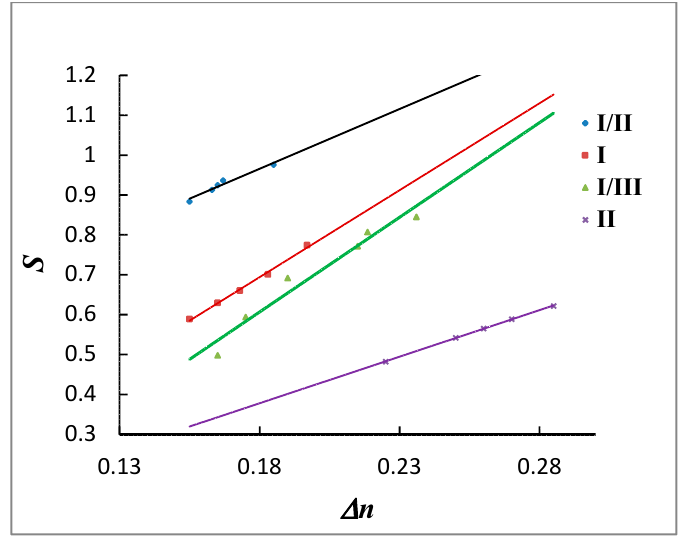
Figure 14. The variable of microscopic parameter ( S ) with birefringence ( ∆ n ) for all samples used.